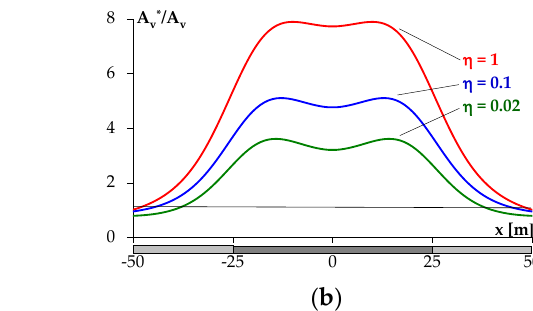
Figure 11. Distribution of the energy concentration coefficient for volumetric strain for different cases of seam extraction in the area: ( a ) the exploitation edge, ( b ) the residual pillar.